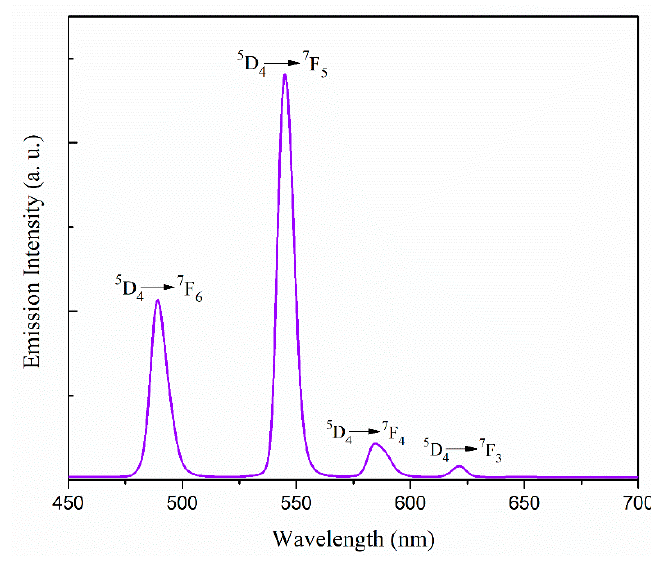
Figure 5. Emission spectrum of complex 2 in acetonitrile at room temperature.